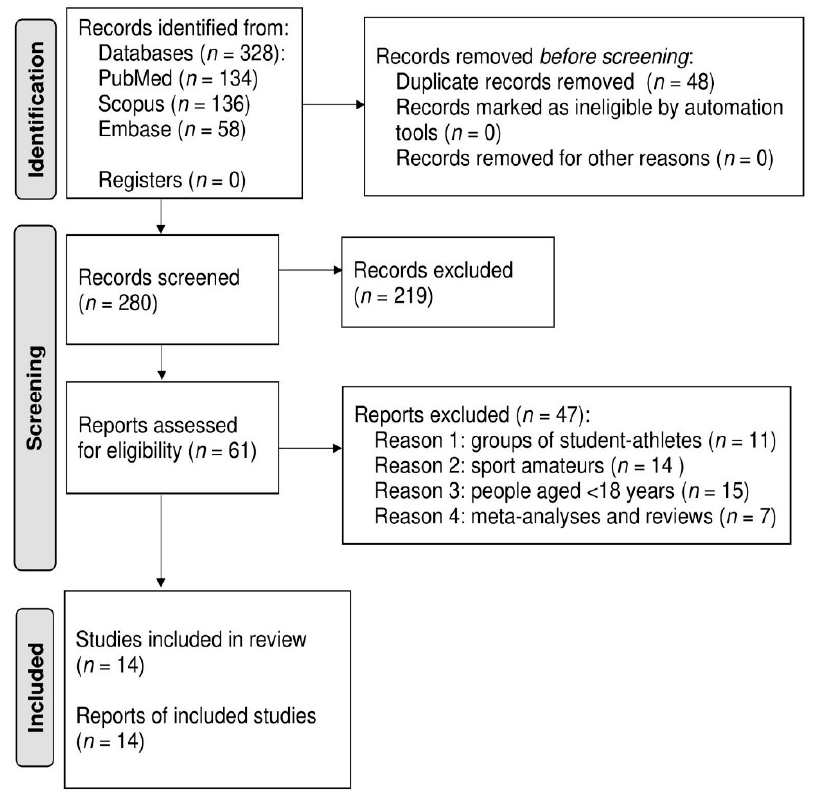
Figure 1. PRISMA flow diagram to depict search strategy results.